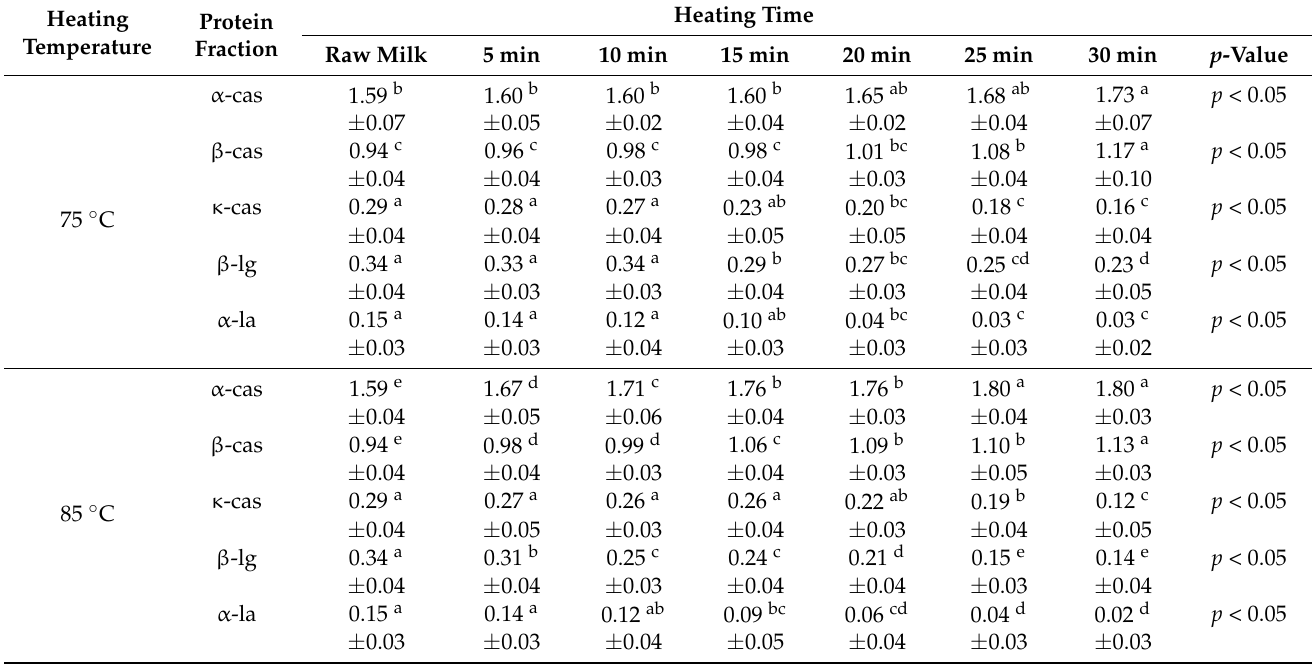
Table 2. Effect of heating temperature and time on the content of protein fractions (g/100mL ± SD).